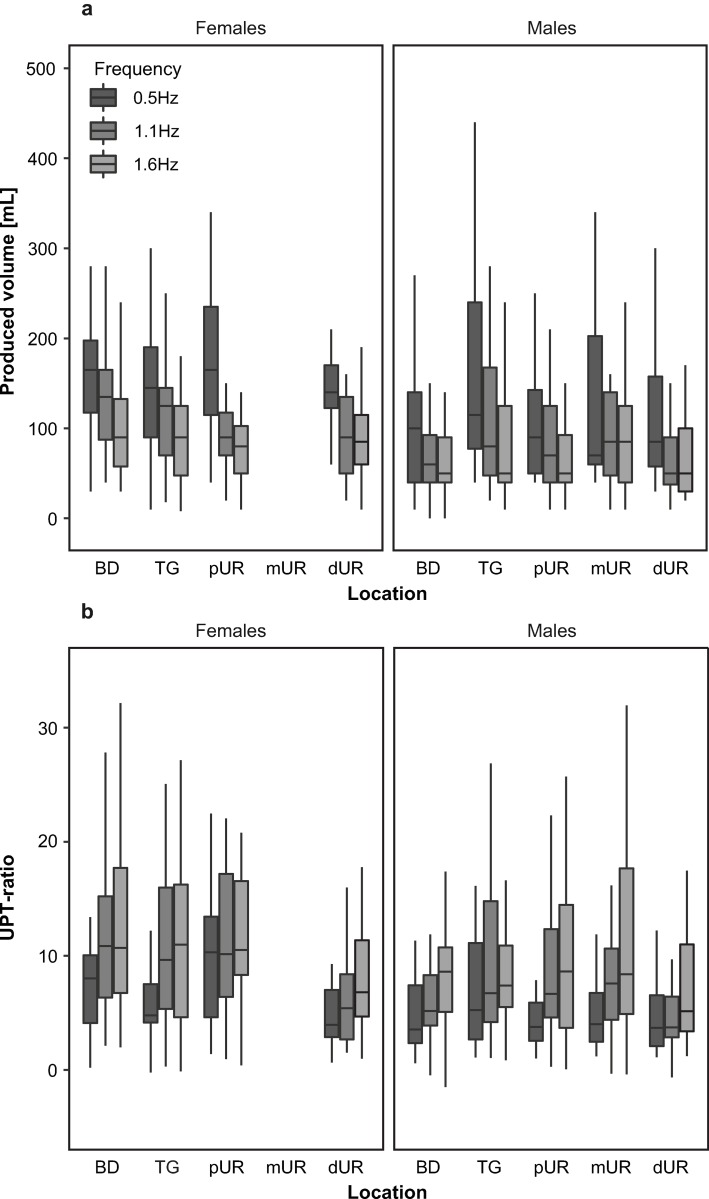
Box plots of median, 25th and 75th percentile and whiskers of urine production.Produced volume [mL] (4a) and urine production per time (UPT)-ratio (4b) are shown for the three stimulation frequencies and five stimulation sites (BD: bladder dome; TG: trigone; pUR: proximal urethra; mUR: membranous urethra; dUR: distal urethra), stratified for gender. Outliers are not displayed.